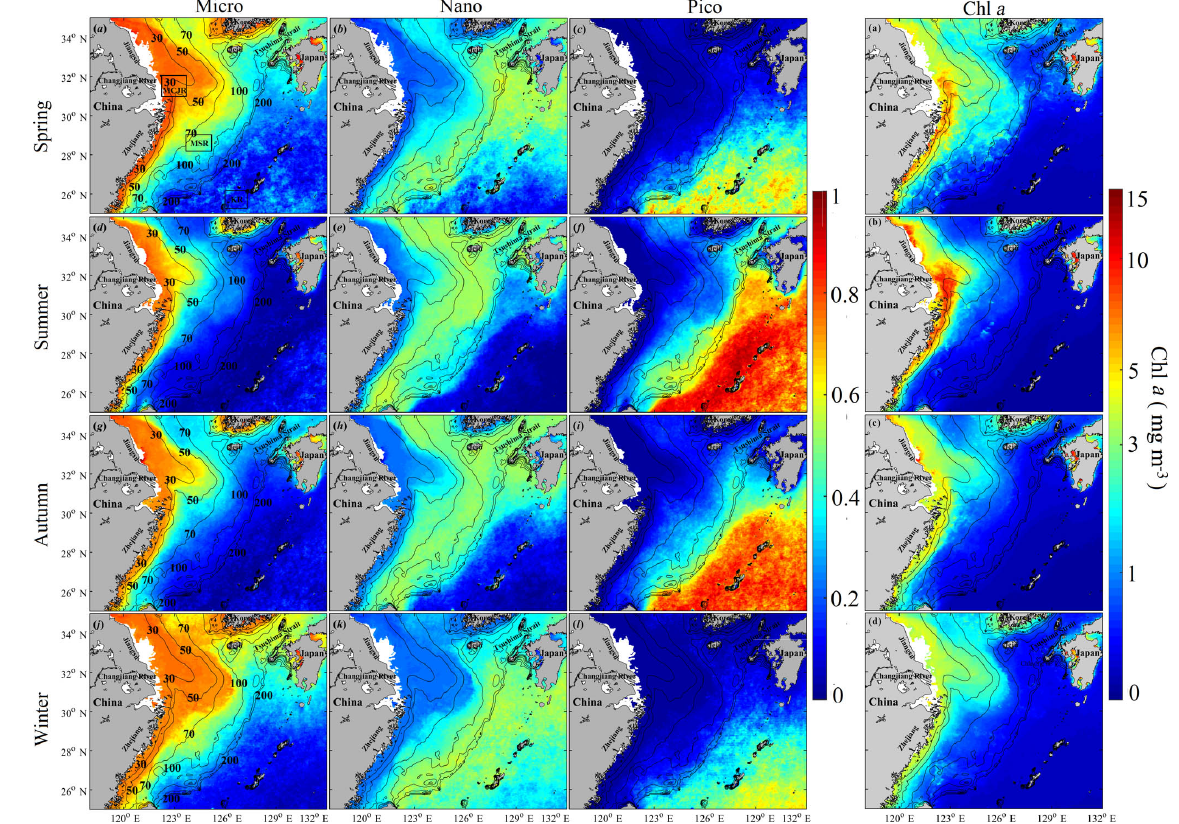
Figure 8. Seasonal distributions of the PSC (a–l) and Chl a ( a–d , right panel) in the ECS during